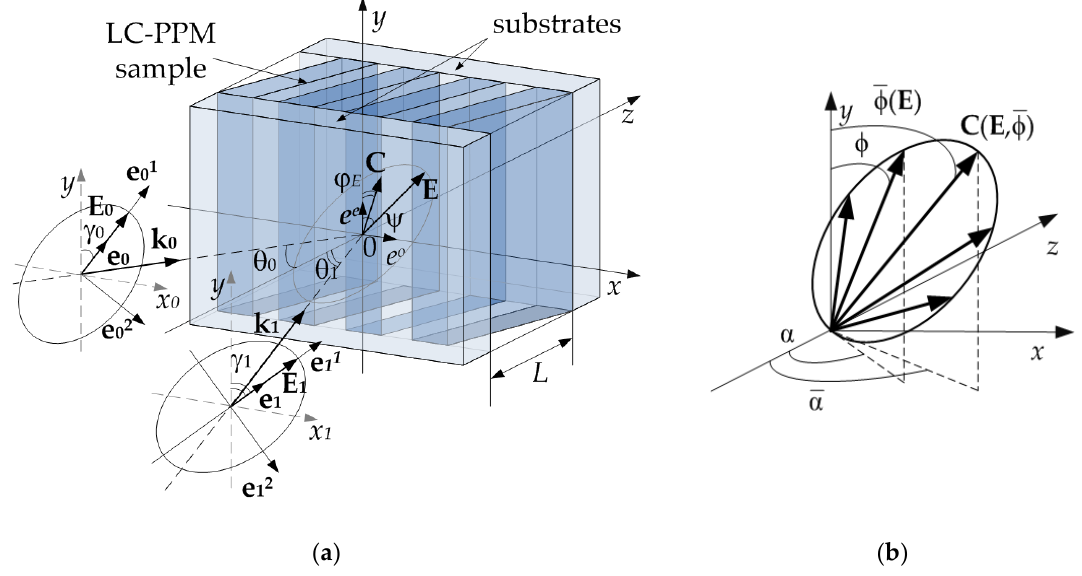
Figure 1. The description of formation of non-uniform HDS in LC-PPM problem: ( a ) Formation geometry; ( b ) the distribution of the LC director in the ellipsoidal droplet.